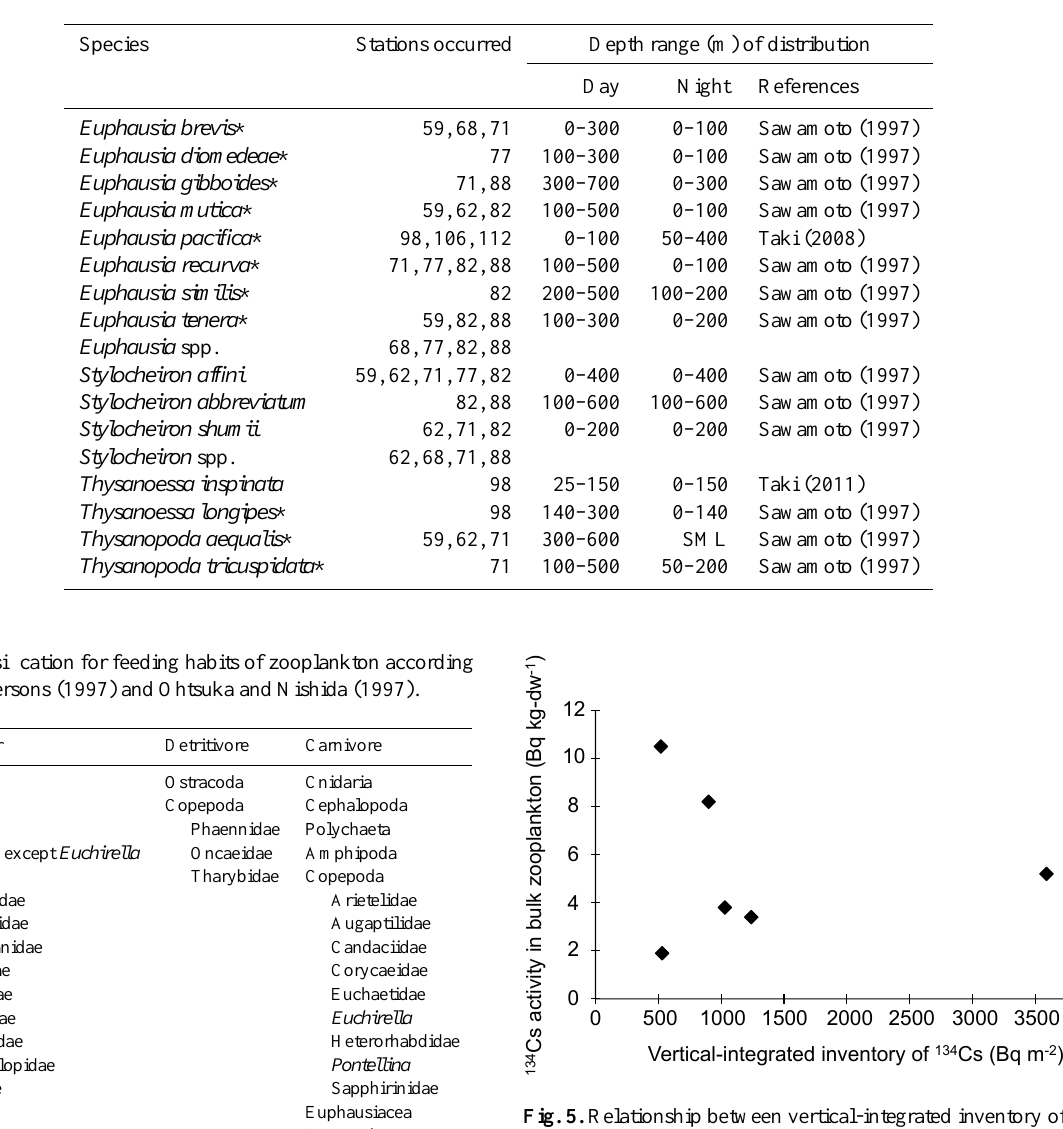
Fig. 5. Relationship between vertical-integrated inventory of 134 Cs (Bqm − 2 ) and 134 Cs activity concentration in bulk zooplankton community (Bqkg-dw − 1 ) . All the activities were decay corrected to the date of